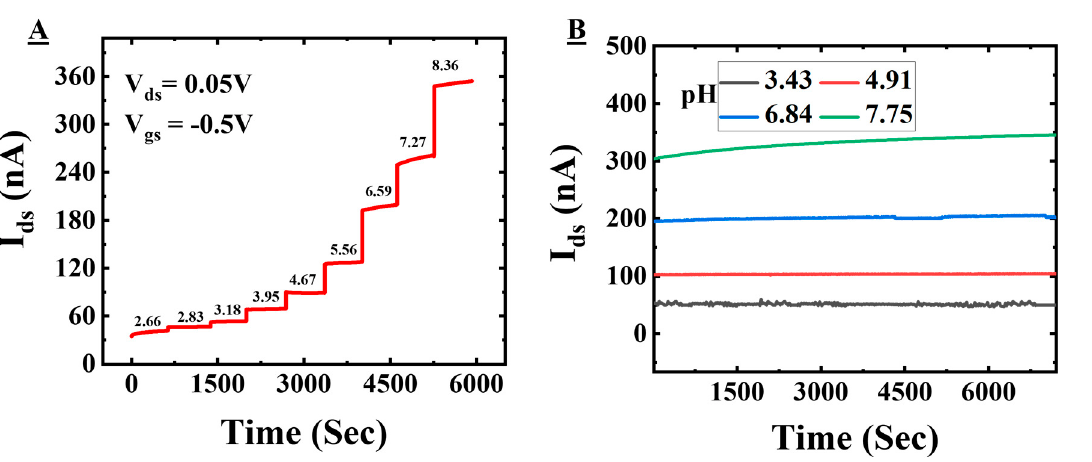
Figure 6. Drift characterization. ( A ) Current vs time step response for different pH and ( B ) current vs time for a longer time for several constant pH values.